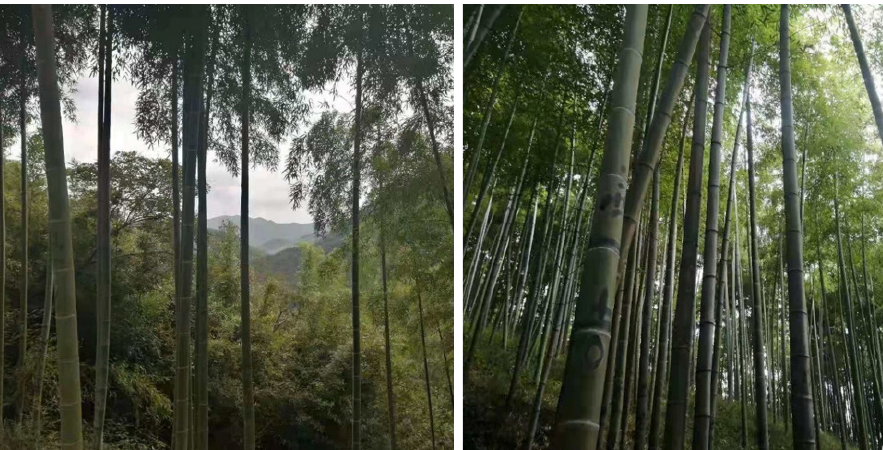
Figure 4: Moso bamboo ( Phyllostachys sp.) groves at Moganshan, Hangzhou, Zhejiang Province, China. © Charlotte King, International Bamboo and Rattan Organization